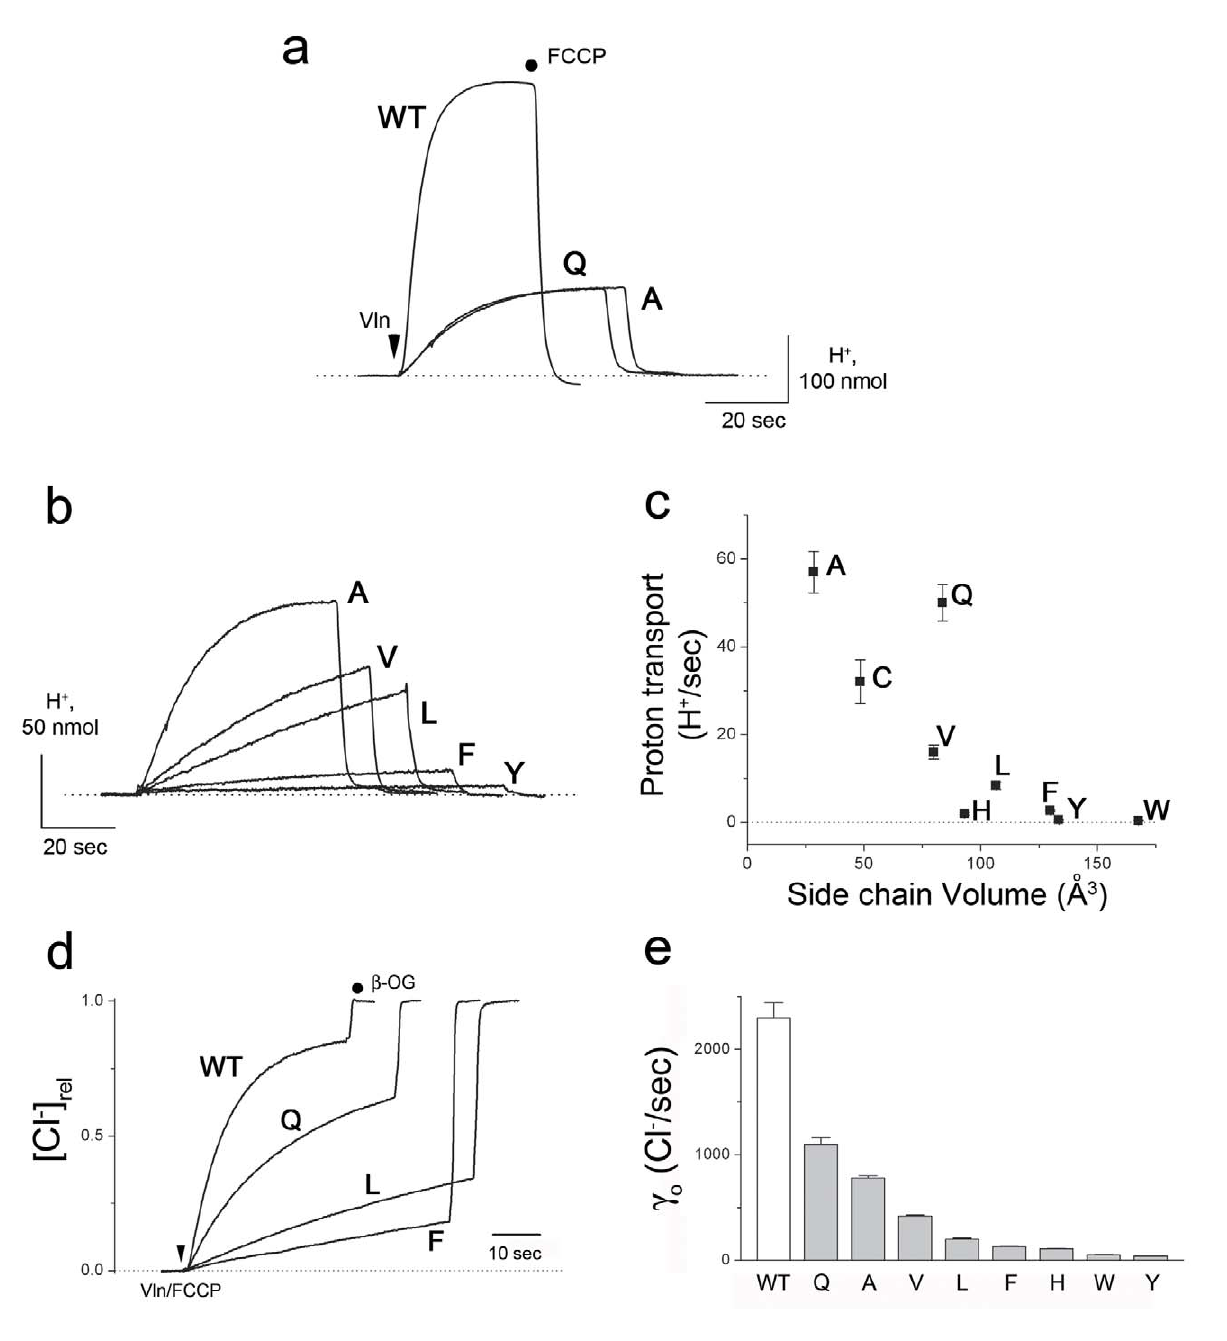
Figure 2. Effect of E202 mutations on Cl 2 -driven H + uptake. (a) H + uptake traces of E202A and E202Q. Transport is initiated by addition of Vln (arrow) and terminated by FCCP, and H + uptake is indicated by upward deflection in the pH traces shown. (b) H + uptake traces with indicated substitutions at E202. (c) Correlation of initial H + uptake rate with side chain volume. (d) Cl 2 efflux traces with indicated substitutions at E202. Cl 2 appearance in the liposome suspension is normalized to final value after addition of b -octylglucoside detergent (after abrupt step in trace). Arrow indicates addition of Vln + FCCP. (e) Summary of initial rates of Cl 2 efflux, c o , for E202 substitutions tested.